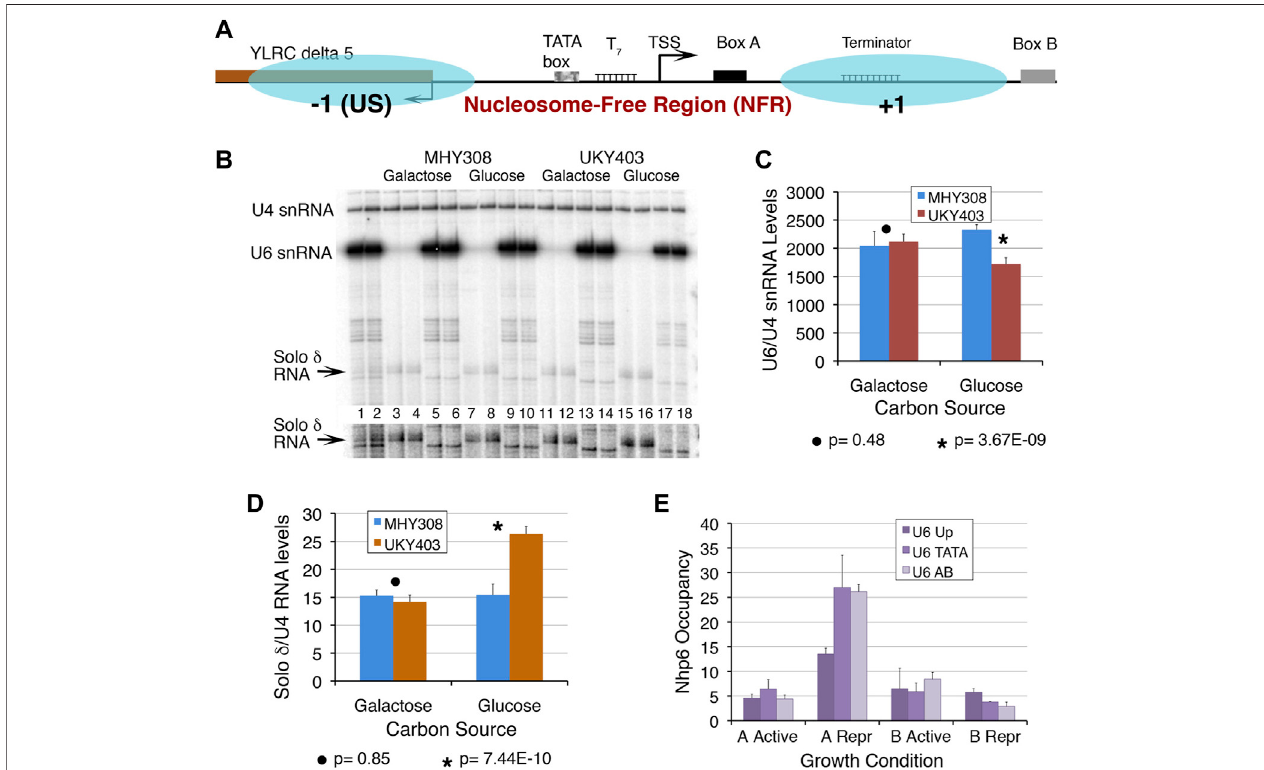
FIGURE 1 | Chromatin at the SNR6 locus affects the U6 snRNA levels. (A) Schematic representation of the SNR6 locus. Blue ovals show two positioned nucleosomes mapped earlier in the gene region (Arimbasseri and Bhargava 2008). Box B is found at the 3 ′ -end of the gene body (+1) nucleosome whereas the − 1 nucleosomeisfoundupstream(US)oftheTATAboxatthe − 30 bpposition.TheTATAbox,T 7 element,TSS(bentarrow),andboxAarefoundintheNFRregion.TheUS nucleosome by virtue of blocking the 5 ′ end of the Ty1 solo δ element ( YLRC δ 5 ) represses its expression. (B) A typical gel showing the primer extension products fromduplicatesamples.Disruptionofthechromatinstructureperturbstranscriptionatthe SNR6 locus.YeaststrainsMHY308andUKY403( SupplementaryTableS1 ) carryhistoneH4genesundertheirownpromoterorthe GAL1 promoter.WhenUKY403cellsareshiftedtoglucoseforgrowth,H4isdepletedcausingalossof50 – 60% of nucleosomes (Kim et al., 1988) by the time the cells get arrested. Cells were grown and processed for total RNA extraction as described earlier (Arimbasseri and Bhargava2008).RNAwasmeasuredbytheprimerextensionmethodusingend-labeledgene-speci fi cprimersforcDNAsynthesisinthreeindependentexperiments.U4 snRNA(polII-transcribed)levelswereused asthenormalizer.Lanes1and2showprimerextension productsontotalRNAfromMHY308and UKY403usingprimersfor U4, U6 snRNAs, and solo δ RNA, added together in the same extension reaction. Alternate pairs ofthe remaining lanes received primers of either solo δ (lanes 3, 4, 7, 8, 11, 12, 15 and 16) or U6 (lanes 5, 6, 9, 10, 13, 14, 17 and 18) along with the probe for U4 snRNA, which was used as the normalizer. A higher exposure of the gel area, cropped to visualize the solo δ RNA better, is given below the gel image. The signi fi cance of changes was con fi rmed by Student ’ s two-tail t -test. The p values are given belowthe graphs. Quanti fi cation results for U6 snRNA (C) and solo δ RNA (D) showing average levels and scatter for four biological replicates. Alarge difference in the y axis scale is due to the very low level of solo δ RNA. (E) Occupancies of Nhp6A and B were measured at three parts of the SNR6 locus in cells expressing HA-tagged Nhp6 A or B proteins. ChIP sample preparation, real-time PCR primers, amplicons, and fold enrichment calculation using TELVIR as the normalizer were as described earlier (Arimbasseri and Bhargava 2008). Samples were prepared from cells grown in an enriched medium (active) or under nutrient-deprivation (Repr; repressed)